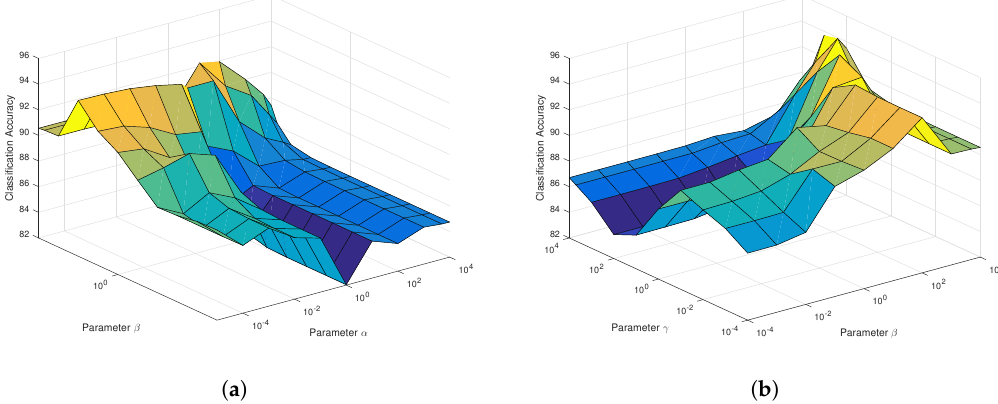
Figure 4. Classification accuracy w.r.t. different regularization parameters on the Pavia University data: ( a ) parameter sensitivity analysis for regularization parameters α , β in SaCGDA. ( b ) parameter sensitivity analysis for regularization parameters β , γ in LapSaCGDA. Table 1. Optimal parameters settings for LapCGDA, SLGDA, SaCGDA and LapSaCGDA on the Pavia University data. Model α β γ LapCGDA 0.1 100 — — SaCGDA 0.0001 — 0.0001